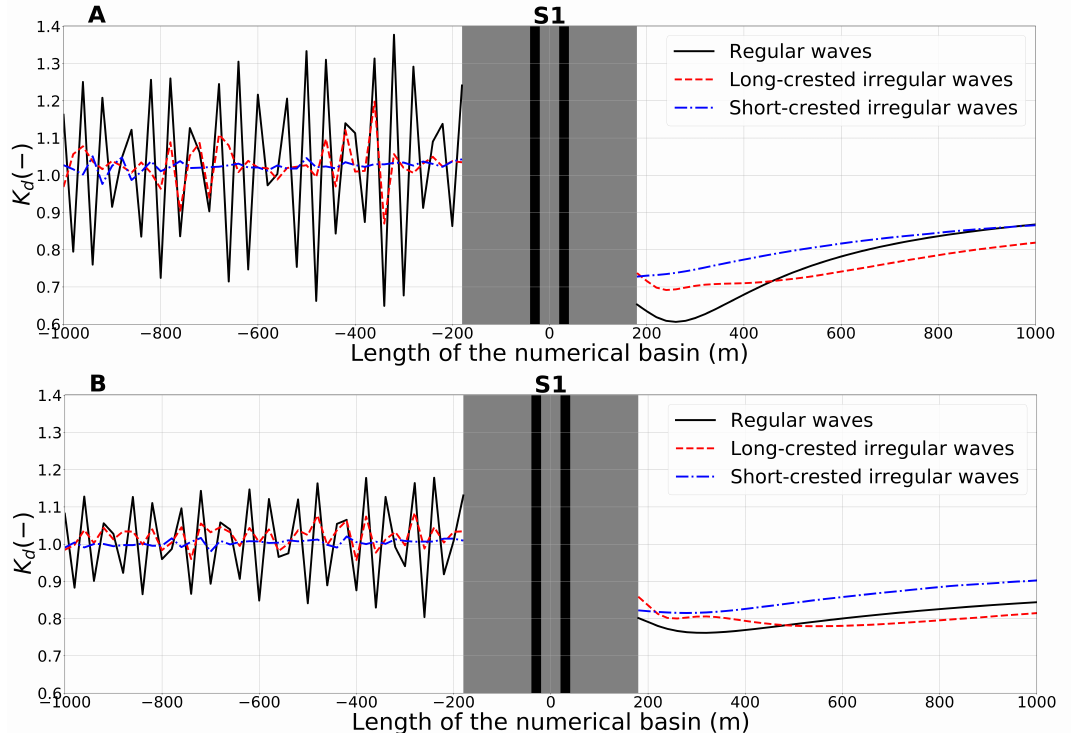
Figure 12. K d disturbance coefficient results along one longitudinal cross-section S1 as indicated in Figures 9–11, for ( A ), a 9-OSWEC (O2) array, and ( B ) a 9-HCWEC array, interacting with regular, irregular long-crested, and irregular short-crested waves, respectively. The results are obtained using the MILDwave-NEMOH coupled. The coupling region is indicated using gray color and includes the WECs’ cross-sections, which are indicated by black vertical